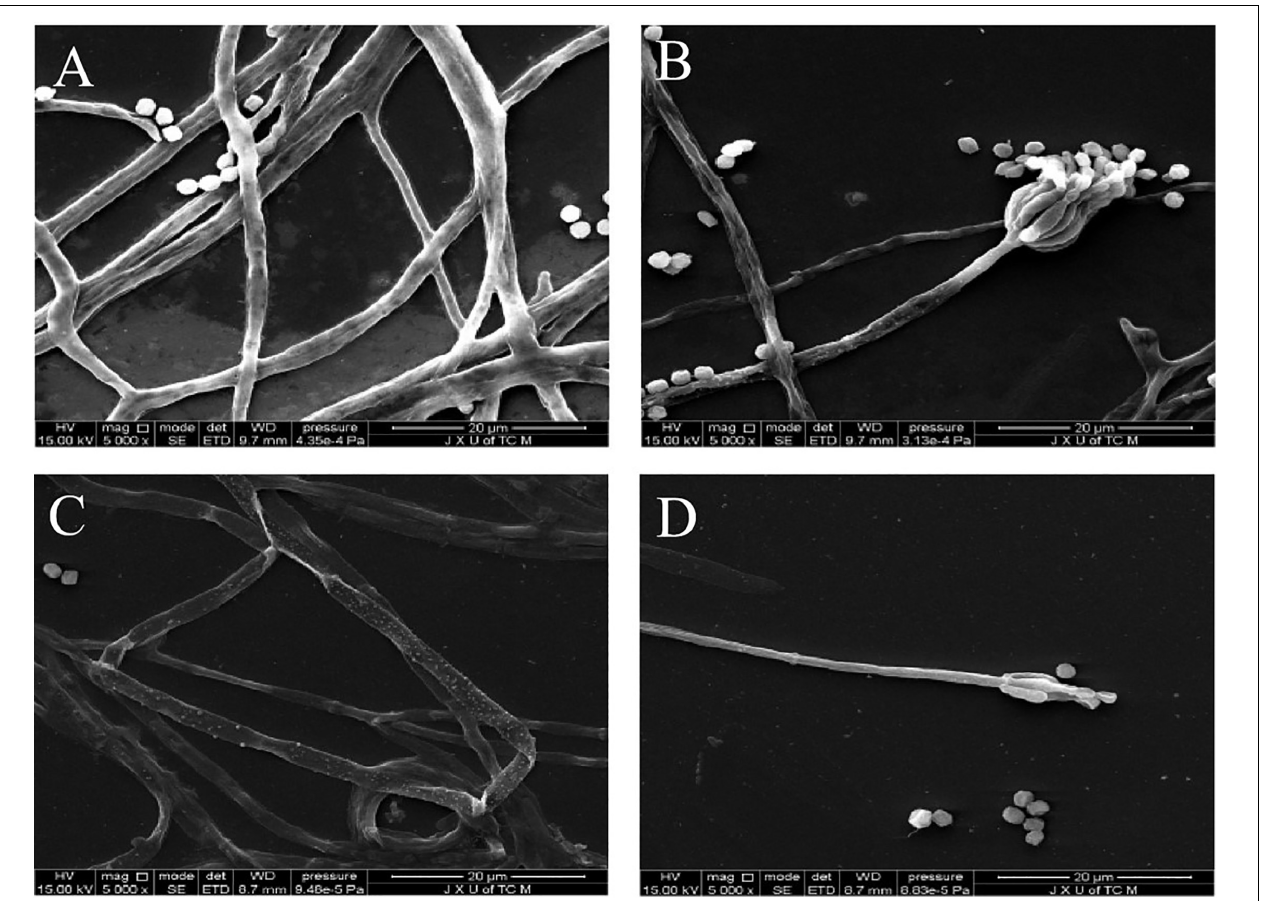
FIGURE 6 | Scanning electron microphotographs of P. digitatum . (A) Untreated mycelia. (B) Untreated spores. (C) Mycelia treated with the X33 antifungal extract at 1.2 mg/mL. (D) Spores treated with the X33 antifungal extract at 1.2 mg/mL.